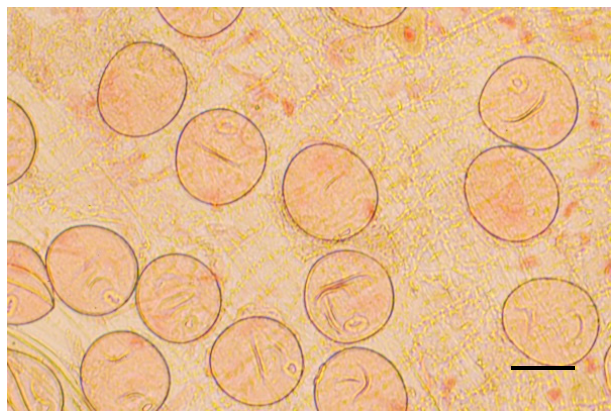
Figure 3. Microspores at the mononuclear stage suitable for anther culture. Bar represents 50 μ